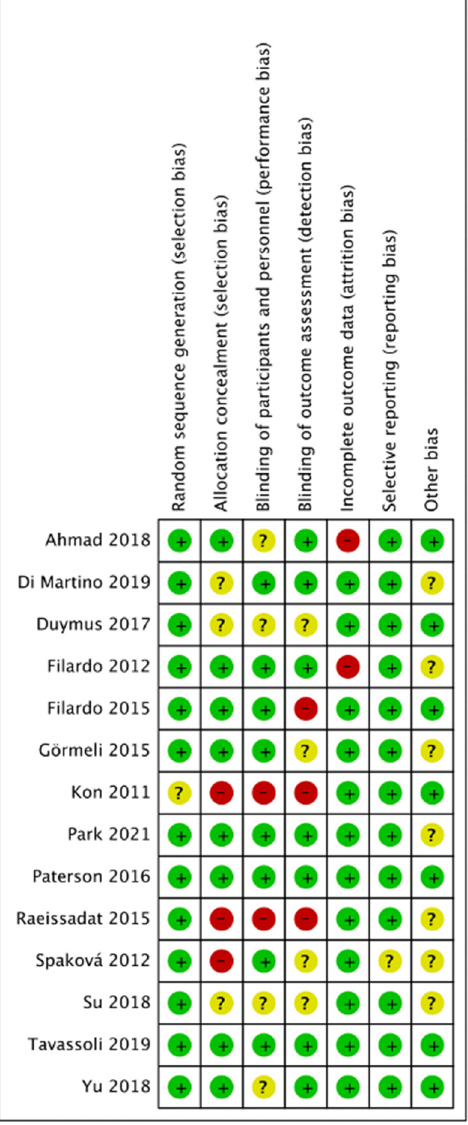
Figure 2. Graph on the risk of bias.